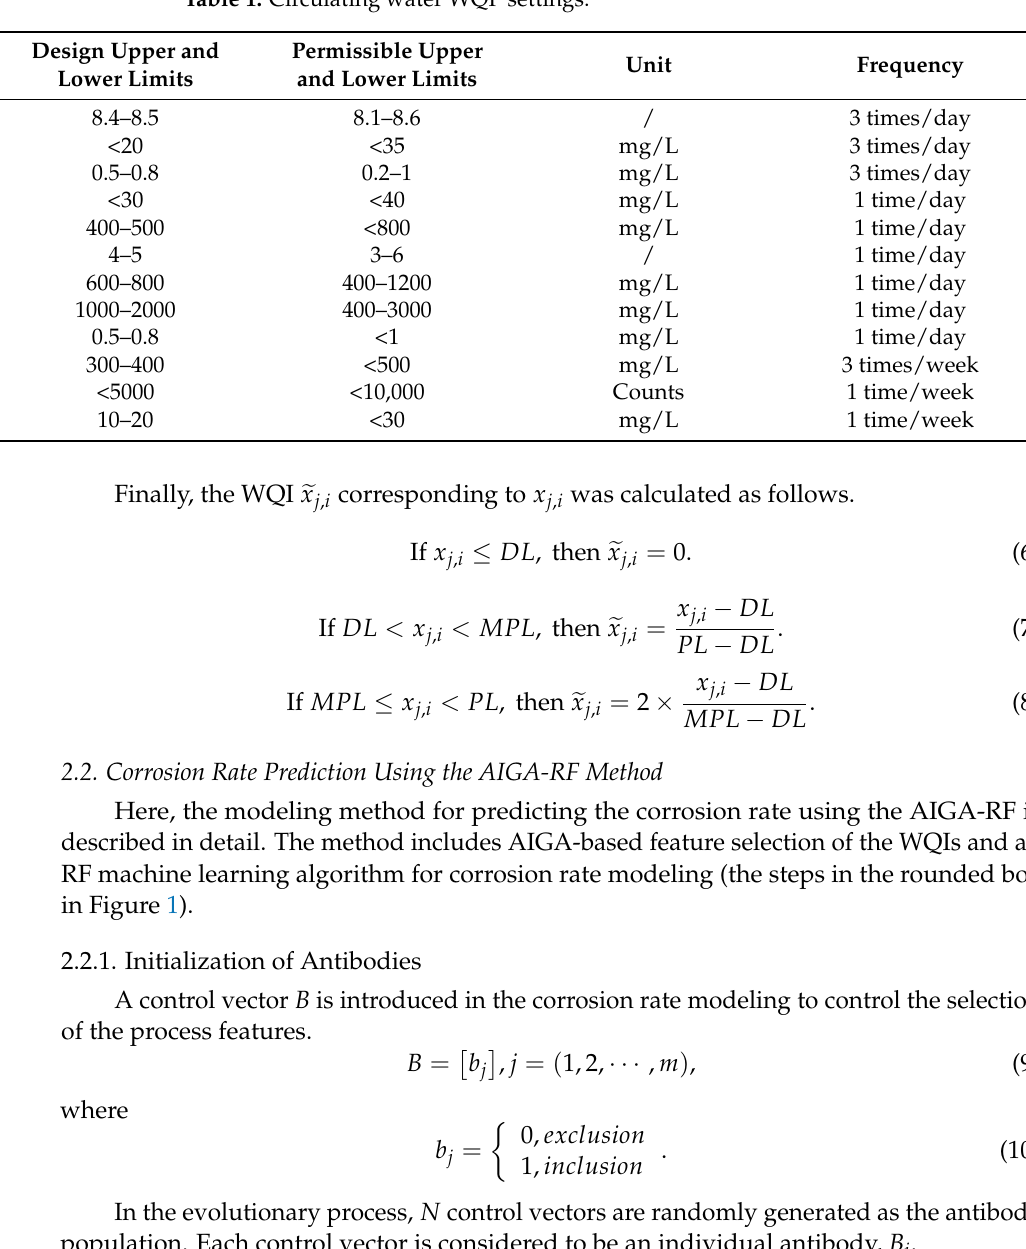
Table 1. Circulating water WQP